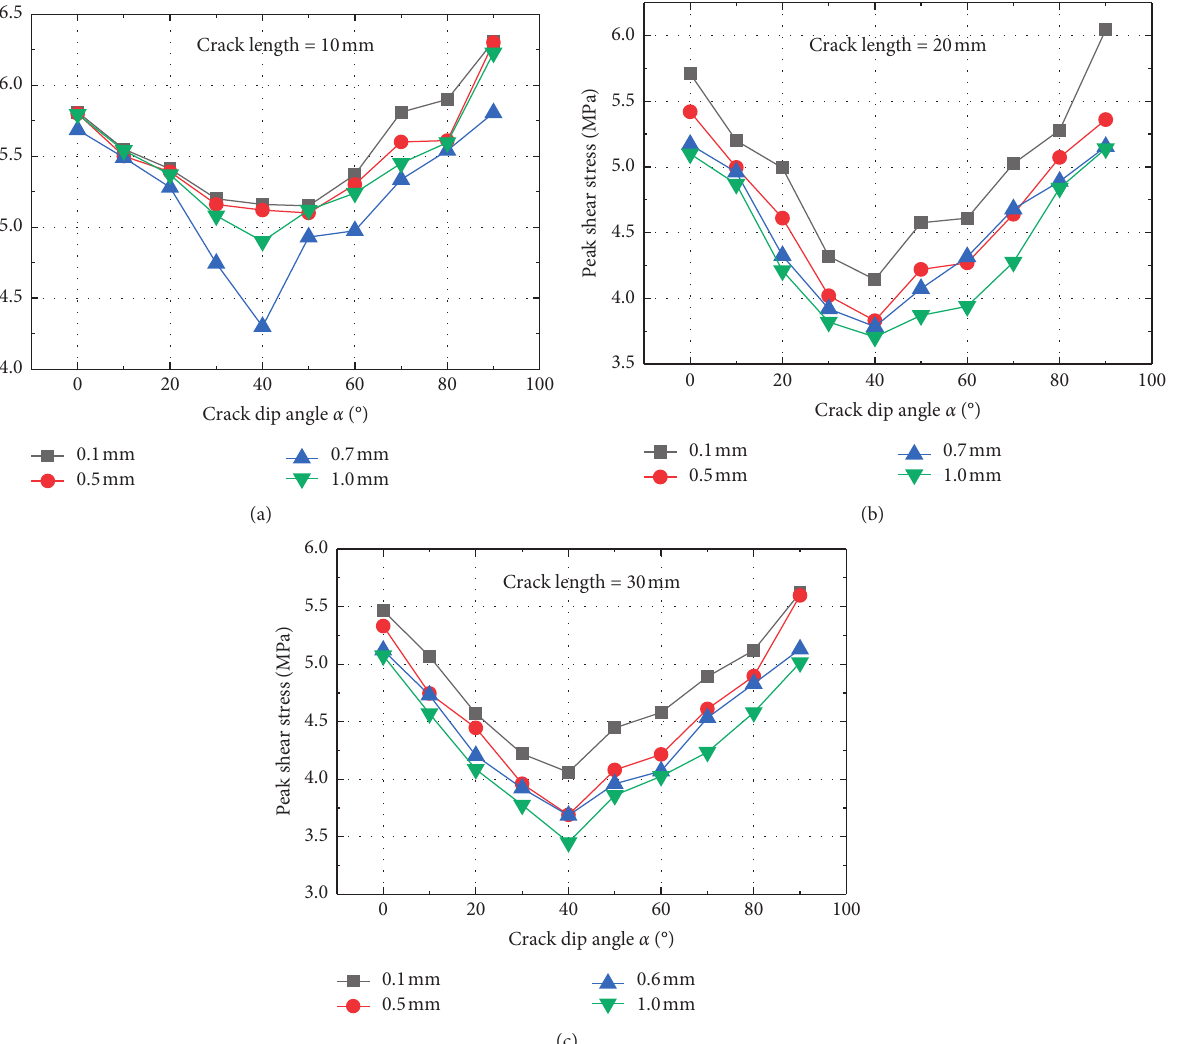
Figure 4: Relation curve between prefabricated fissures with different dip angles and peak shear strength of